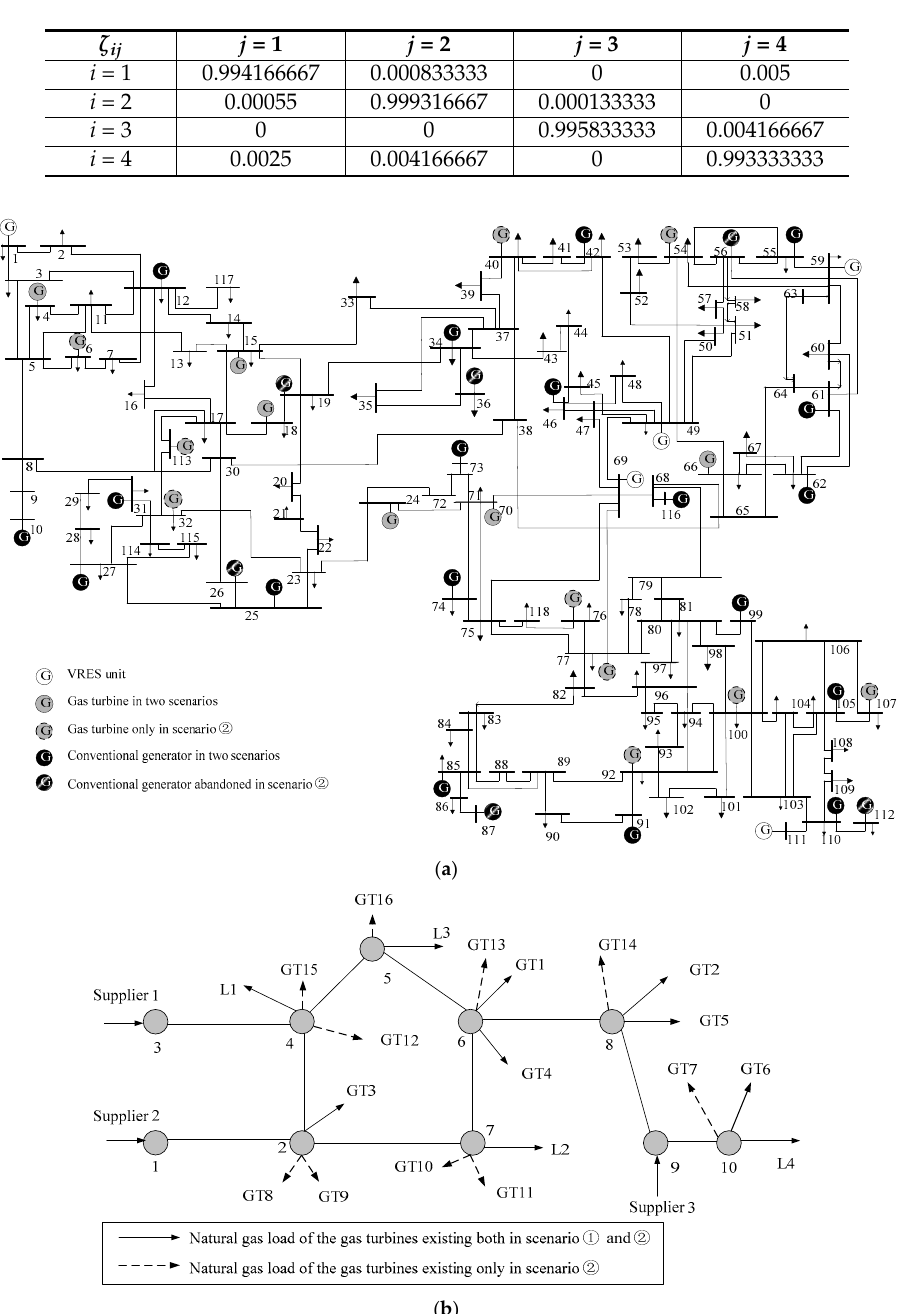
Table 2. Transition matrix of the GT unit [26].